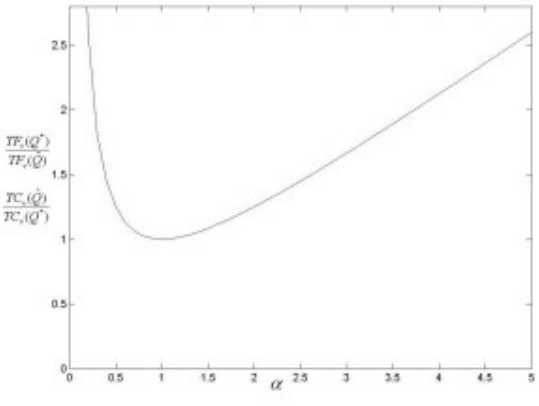
Figure 1. Ratio of objective function value and